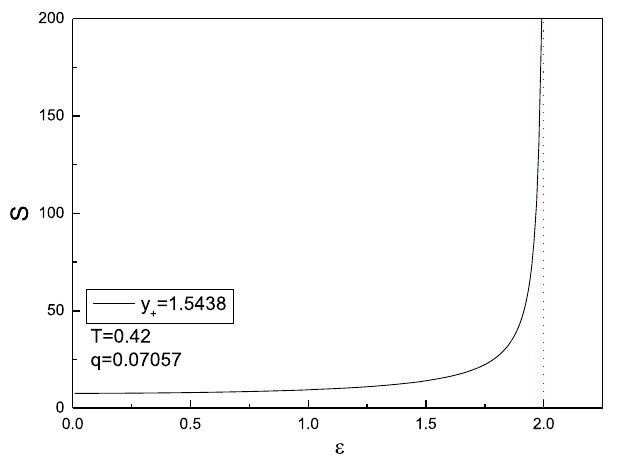
Fig. 6 The entropy as functions of boundary rotation parameter ε for thetemperature T = 0 . 42andthecharge q = 0 . 07057.Left:theentropy against boundary rotation parameter ε for the large branch of black hole solutions y + = 1 . 5438. Right: the entropy against boundary rotation